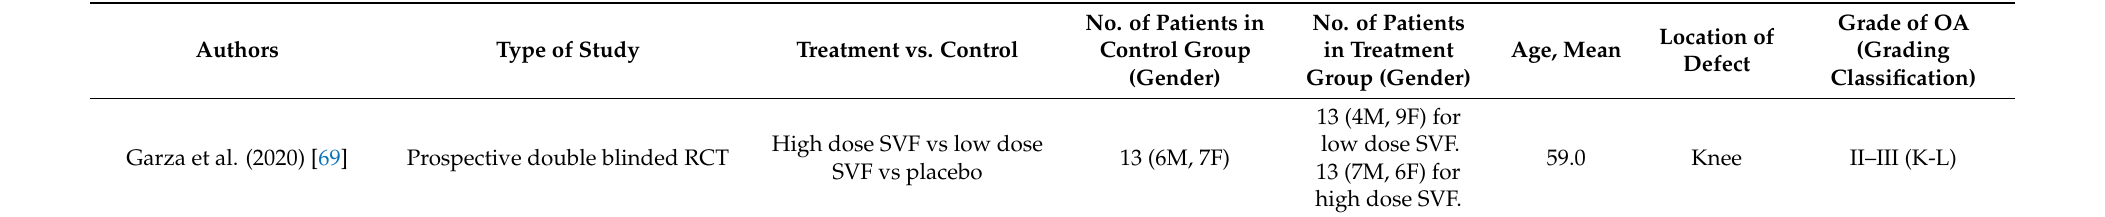
Table 2. Study characteristics for SVF studies, n =